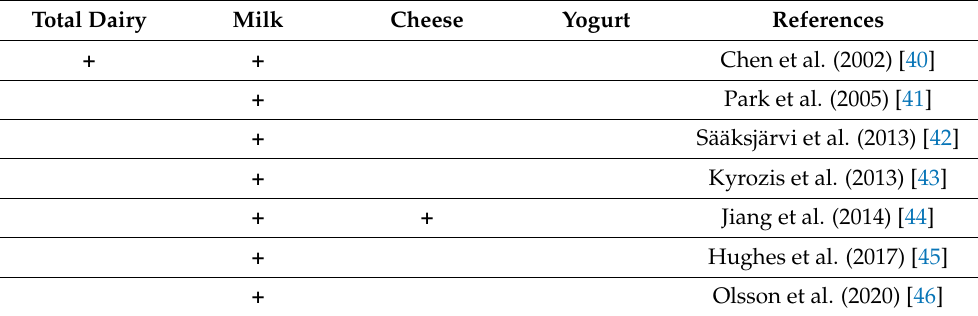
Table 1. Epidemiological evidence for milk/dairy intake and risk of Parkinson’s disease. Total Dairy Milk Cheese